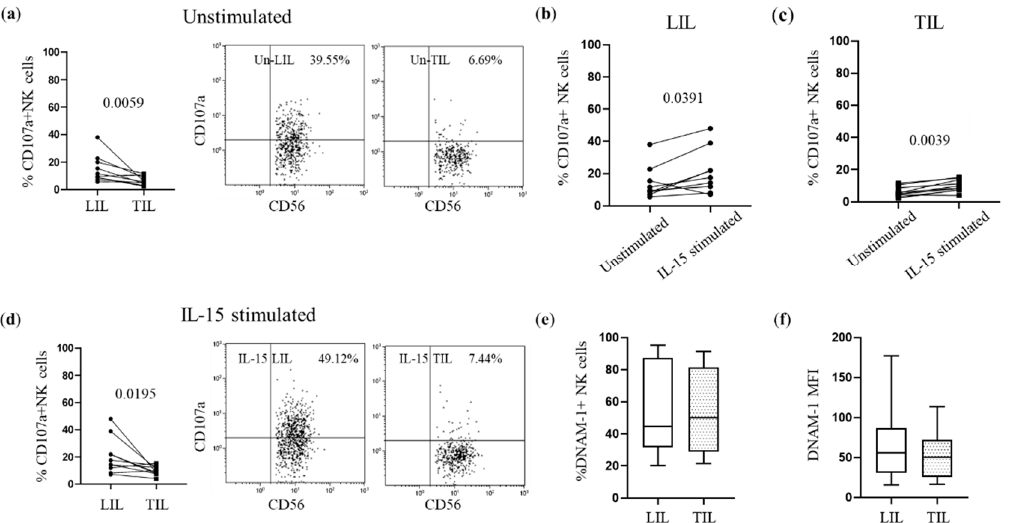
Figure 6. Impaired NK-TIL degranulation activity mediated by DNAM-1. ( a , d ) Degranulation of NK-LIL and matched NK-TIL was analyzed after DNAM-1 triggering in rADCC assays in 10 HCC patients before and after IL-15 stimulation. Representative dot plots showing unstimulated (Un-LIL, Un-TIL) or IL-15 stimulated (IL-15 LIL, IL-15 TIL) cells. ( b , c ) IL-15 stimulation increased cytotoxic activity in NK-LIL and matched NK-TIL. ( e ) Proportion of DNAM-1+ NK cells and ( f ) expression of DNAM-1 receptor in NK cells from IL-15 stimulated LIL and TIL. The non-parametric Wilcoxon matched-pairs signed-rank test was used to compare